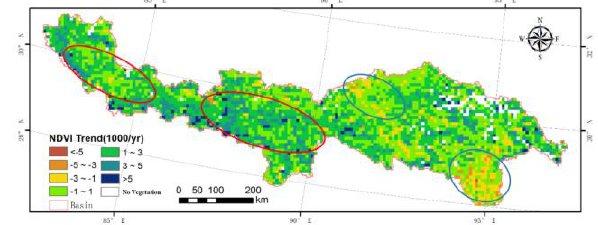
Figure 7. Spatial pattern of NDVI trends from 1982 to 2013